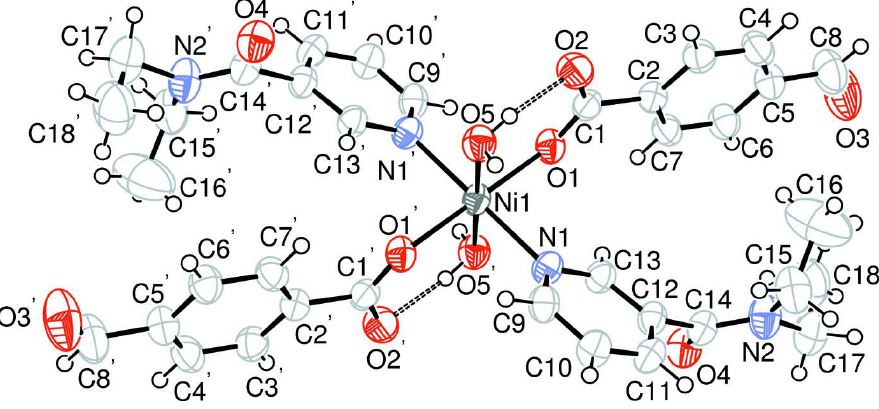
The molecular structure of the title compound with the atom-numbering scheme. Displacement ellipsoids are drawn at the 50% probability level. Hydrogen bonds are shown as dashed lines. Primed atoms are generated by the symmetry operator (- x , - y , - z